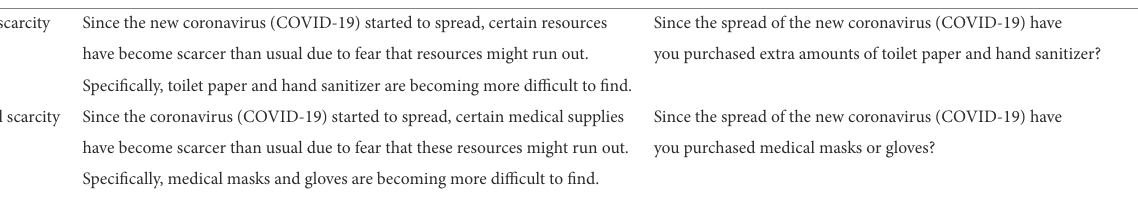
TABLE 3 Dilemma